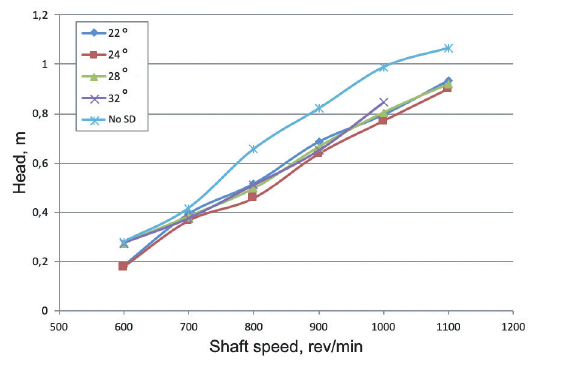
Figure 4. Pump head as a function of the shaft speed for differ- ent SD